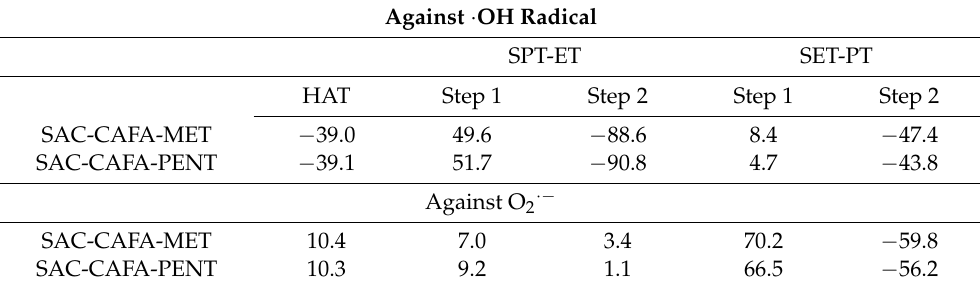
Table 2. Calculated reaction free energies ( ∆ G, kcal · mol − 1 ) under standard conditions in water for HAT, SPT–ET, and SET–PT reaction channels between SAC-CAFA-MET, SAC-CAFA-PENT, and selected ROS. Against · OH Radical SPT-ET SET-PT HAT Step 1 Step 2 Step 1 Step 2 SAC-CAFA-MET −